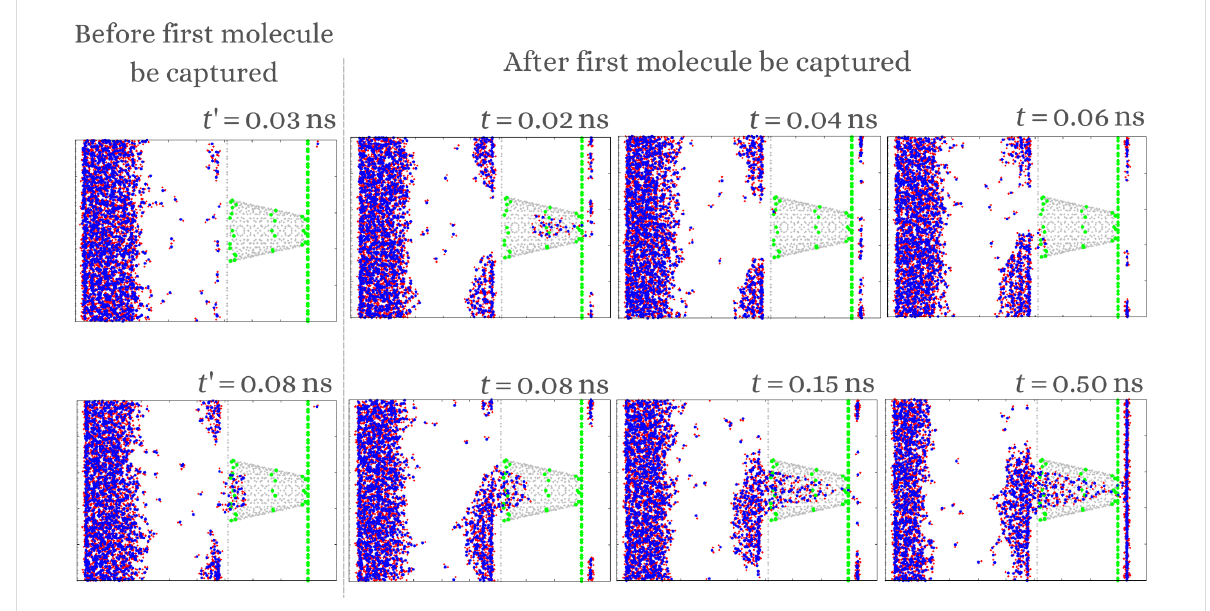
Figure 4: Snapshots of the temporal evolution of the vapor system using ε i = 1.1.